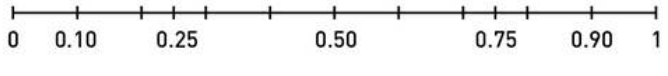
Figure 2. Probability scale.